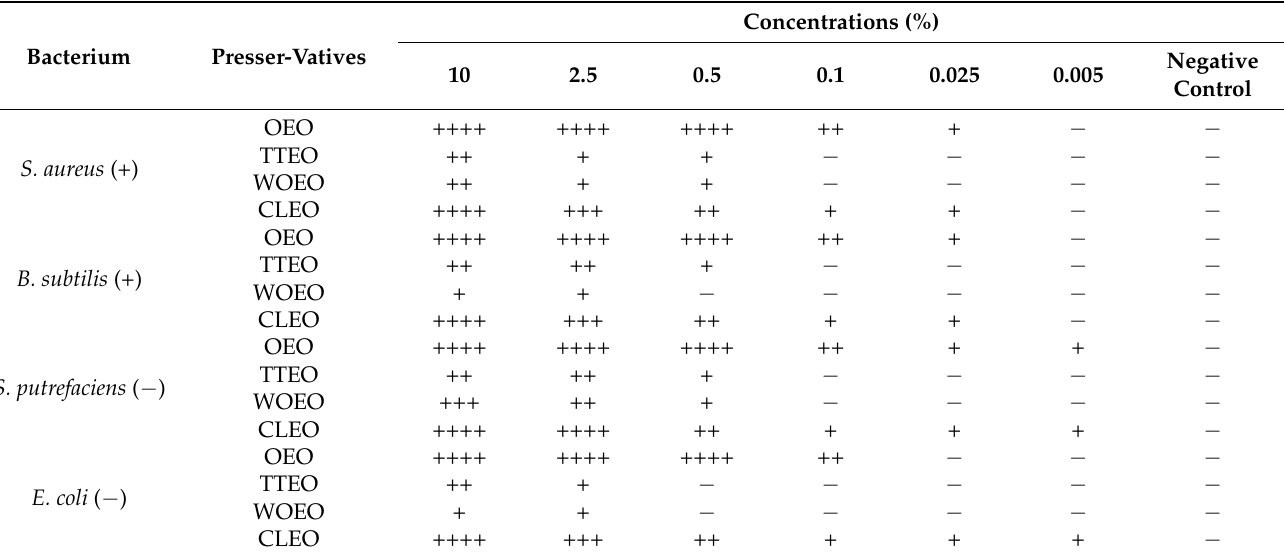
Table 2. The sensitivity of the four bacterial species to the four essential oils.